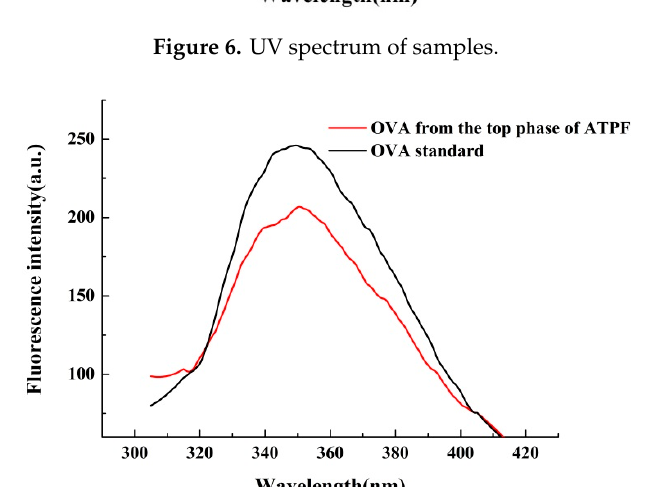
Figure 7 . The fluorescence spectrum of the samples . Figure 7. The fluorescence spectrum of the